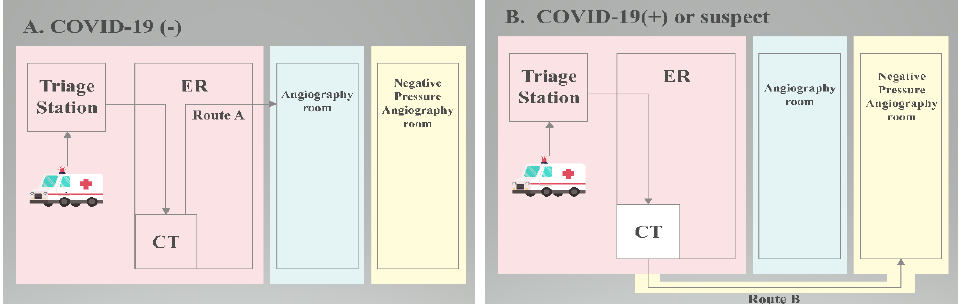
Figure 5. Patients suspected of acute ischemic stroke were immediately tested for COVID-19 PCR at the triage station in the emergency department and then sent to the CT room. Flow chart: ( A ) regular return visits. ( B ) Exceptional circumstances require isolation procedures. (ER: Emergency Room. CT: Computed Tomography.)